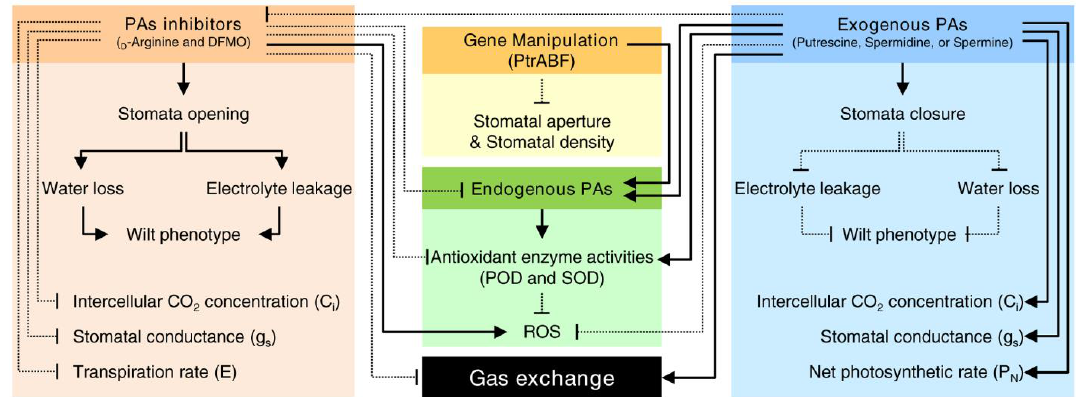
Figure 7. Hypothetical model of the e ff ect of exogenous polyamines (PAs) and PAs biosynthesis inhibitors on gas exchange and its related parameters of citrus plants. Solid lines with arrows signify positive reaction, while round-dotted lines with bar-ends indicate negative interaction.